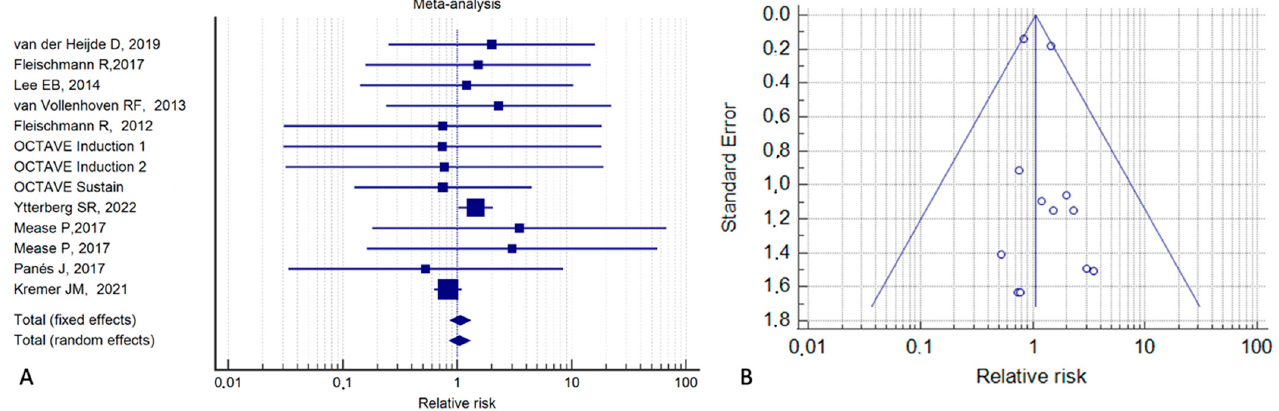
Figure 2. Risk of malignancy in tofacitinib-treated patients vs. control patients who received a placebo or an active treatment ( A ). Corresponding funnel plot ( B )